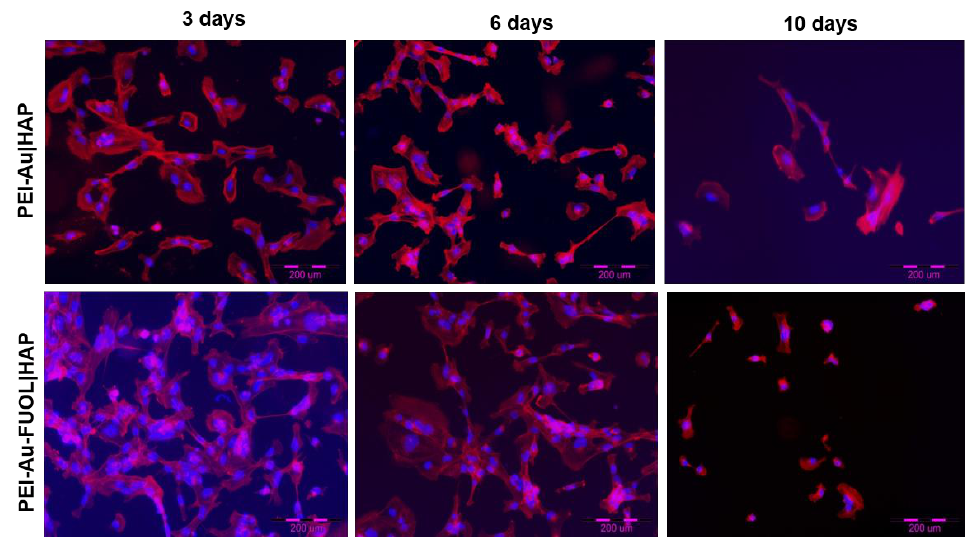
Figure 10. Visualization of cultured hFOB cells grown on a PEI-Au|HAP and PEI-Au-FUOL|HAP membranes after 3, 6, and 10 days. The nuclei of cells are stained in blue. The red fluorescence shows F-Actin. Abbreviations : Au, gold nanoparticles; HAP, hydroxyapatite, hFOB, Human Fetal Osteoblasts; PEI, polyethylenimine.